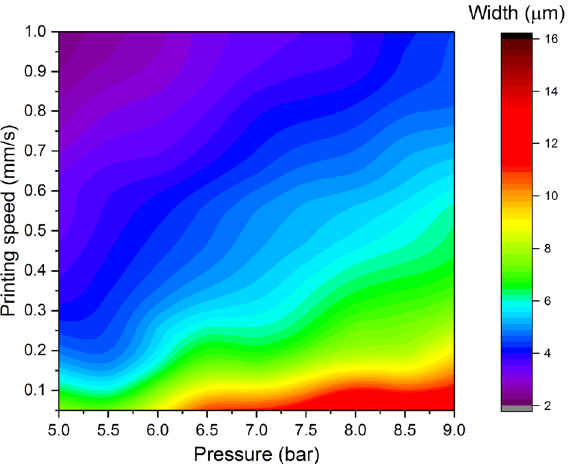
Figure 7. Line width as a function of the printing pressure and printing speed for the nozzle with the opening of 5 µm.